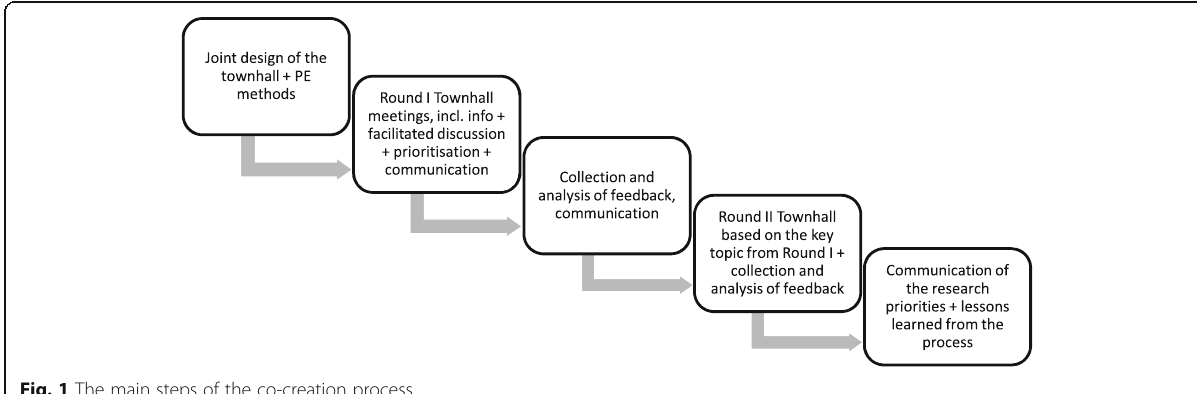
Fig. 1 The main steps of the co-creation